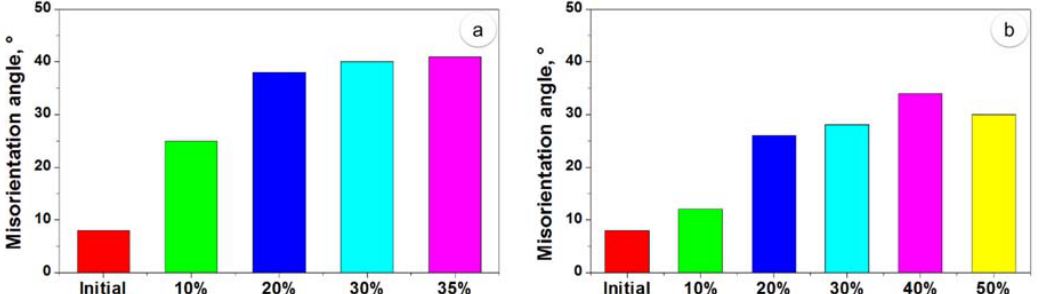
Figure 6. Comparative representation of δ -phase maximum misorientation angle distribution for the UNS 32750 alloy deformed at 1050 °C ( a ) and deformed at 1300 °C ( b ). Dynamic recrystallization (DRX) is another phenomenon that occurs during upset forging at